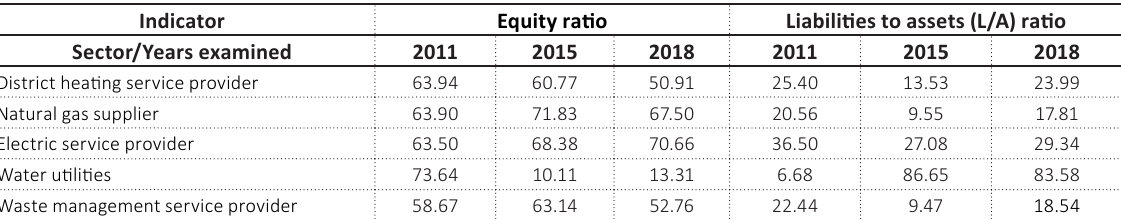
Table 2. Changes in the asset situation of corporations examined in 2011, 2015 and 2018 (data are in numerical